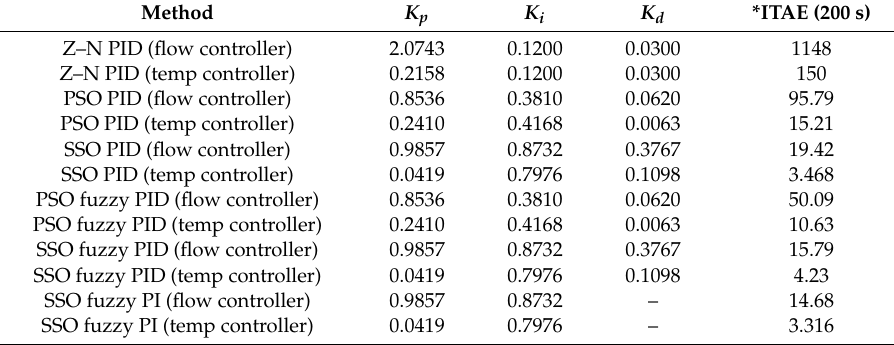
Figure 23. Temperature versus time plot for PI tuned with SSO and SSO fuzzy. Table 6. K p , K i , K d , and ITAE of different tuning methods. *ITAE: Integral of absolute error multiplied by time.